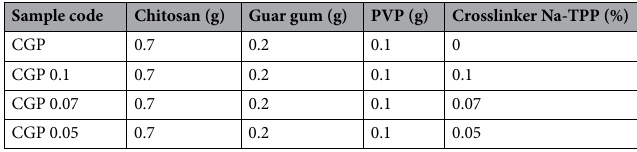
Table 1. Sample codes along with the quantities of components of hydrogels.